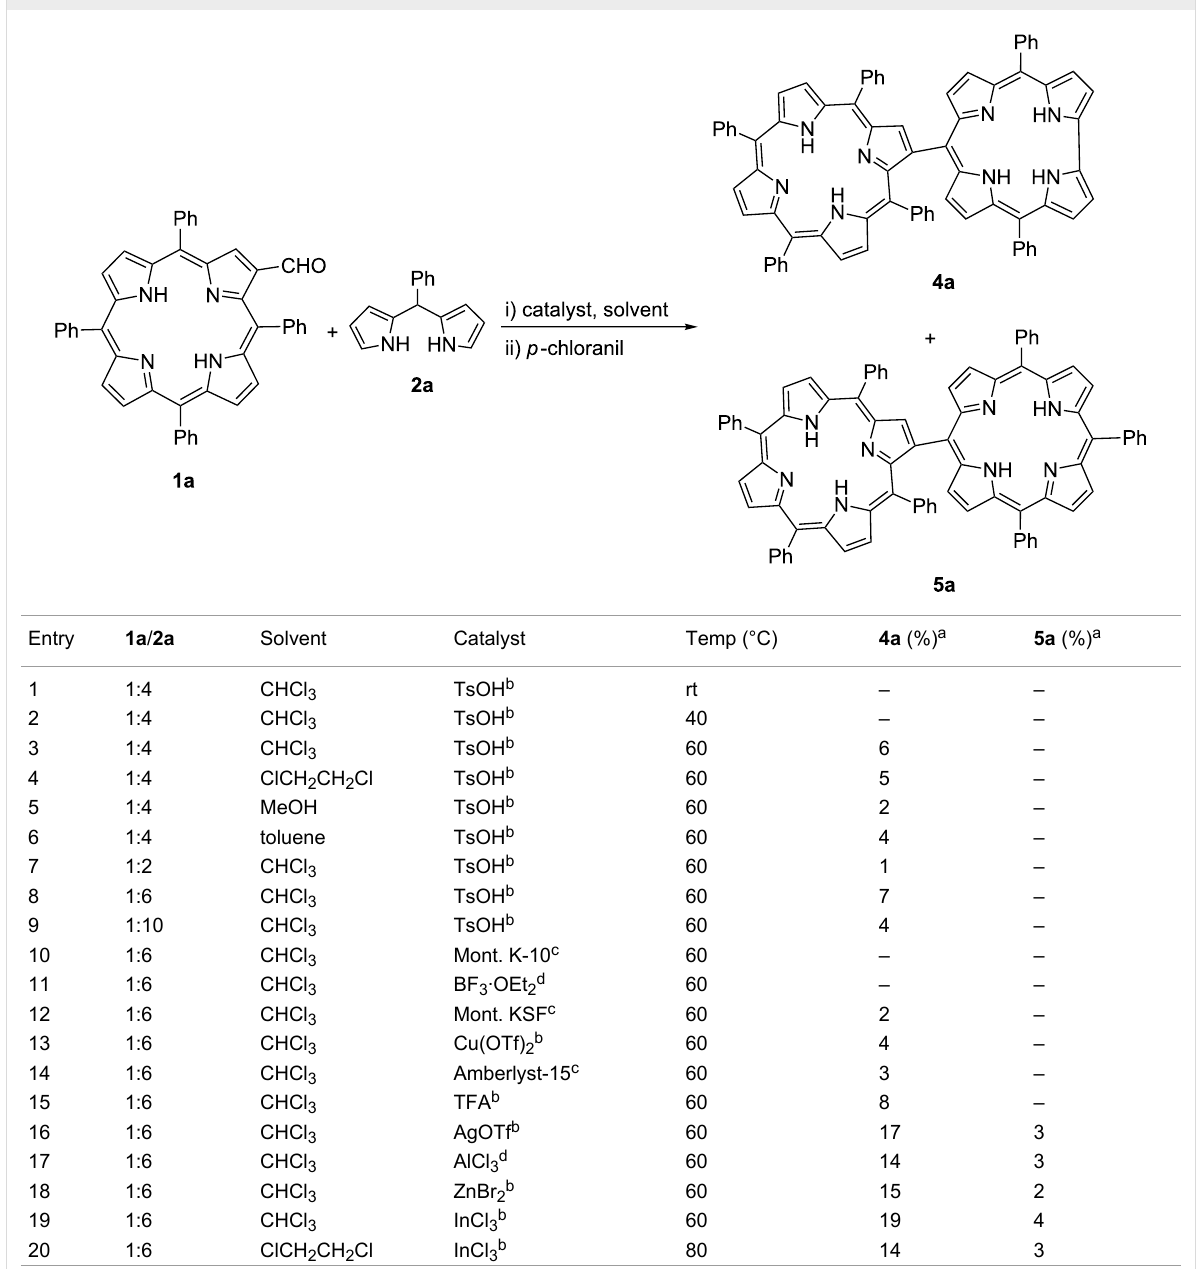
Table 1: Optimization of the reaction